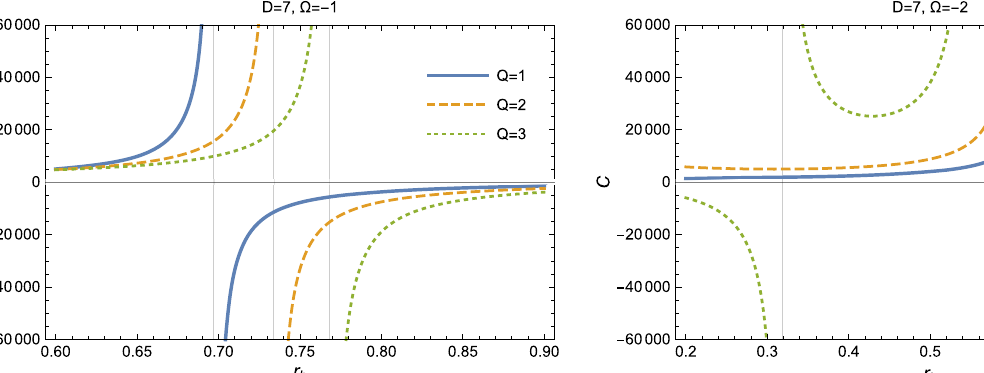
Fig. 2 The plots show how the heat capacity behaves for different val- ues of q . We have chosen the parameters as κ = 1, D = 7, ˜ α 0 = − 1 and ˜ α 1 = ˜ α 2 = ˜ α 3 = 1. At (cid:5) = − 1 the point r h = r c where the